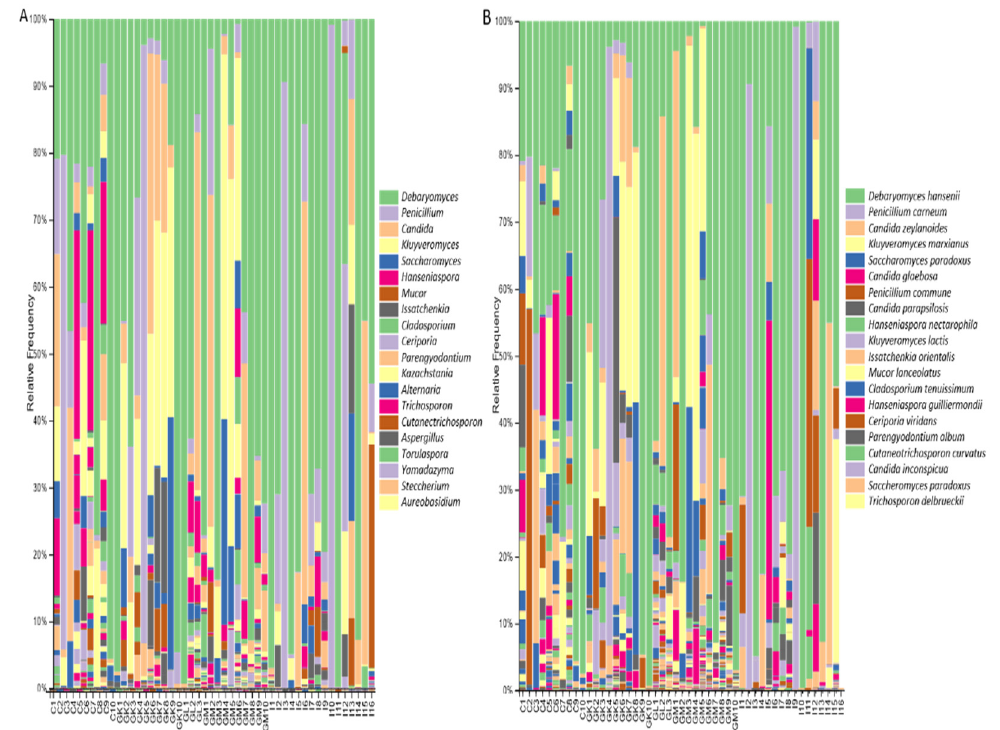
Figure 5. The relative abundance of the twenty most abundant fungi identified at: ( A ) the genus level; ( B ) the species level, based on ITS loci sequencing for Cyprus, Greek, and Irish cheeses